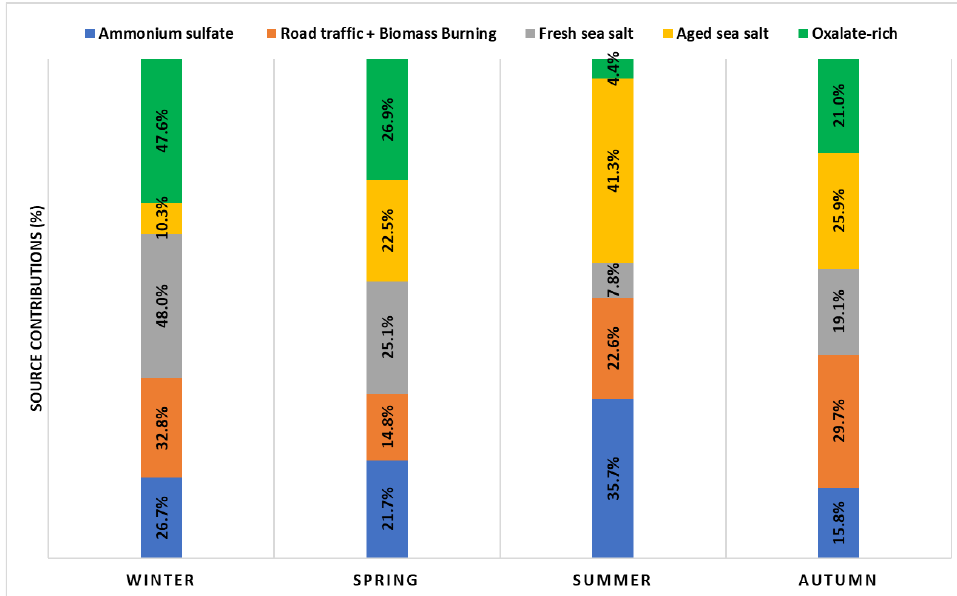
Figure 6. Seasonal contribution of the PMF-resolved sources to the PM 2.5 mass. The road traffic and biomass burning emissions factor (Factor 2) is dominated by Table 4. Summary of PMF-resolved sources and their specific tracers. high contributions of black carbon (BC, 64.1%) and organic carbon (OC, 64.3%) with the presence of a trace amount of calcium (Ca 2+ , 21.5%) and potassium (K + , 19.2%). This factor is found to contribute the most among all the identified factors to the PM